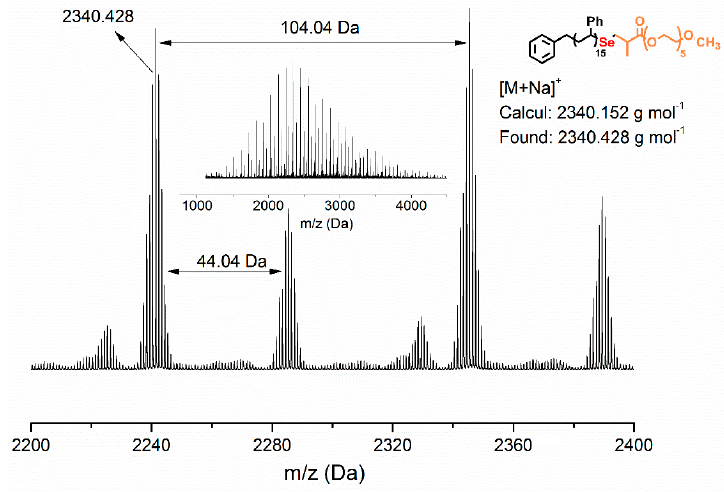
Figure 4. 1 H NMR (in CDCl 3 ) spectrum of PS-Se-1- b -PEGMA 320 ( M n,SEC = 2700 g mol − 1 , Ɖ = 1.09).